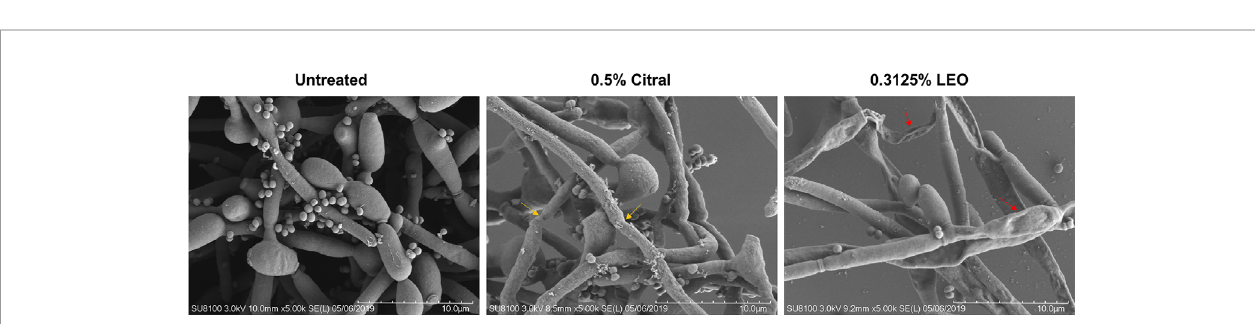
FIGURE 7 | Observation of the inhibitory effects of lemongrass essential oil or citral on the microstructure of dual-species bio fi lms by SEM microscopy. LEO, lemongrass essential oil. Yellow arrows indicate fragile hyphae segmentation and red arrows indicate the shrunk surface on the Candida hyphae.